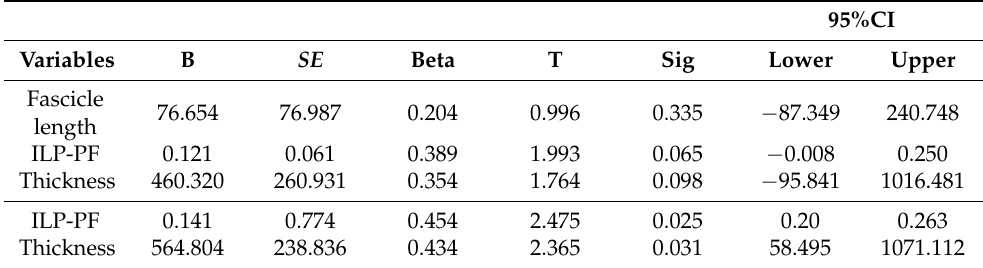
Table 5. Results of the stepwise regression analysis using ILP-PF, fascicle length and muscle thickness as predictors of CMJ